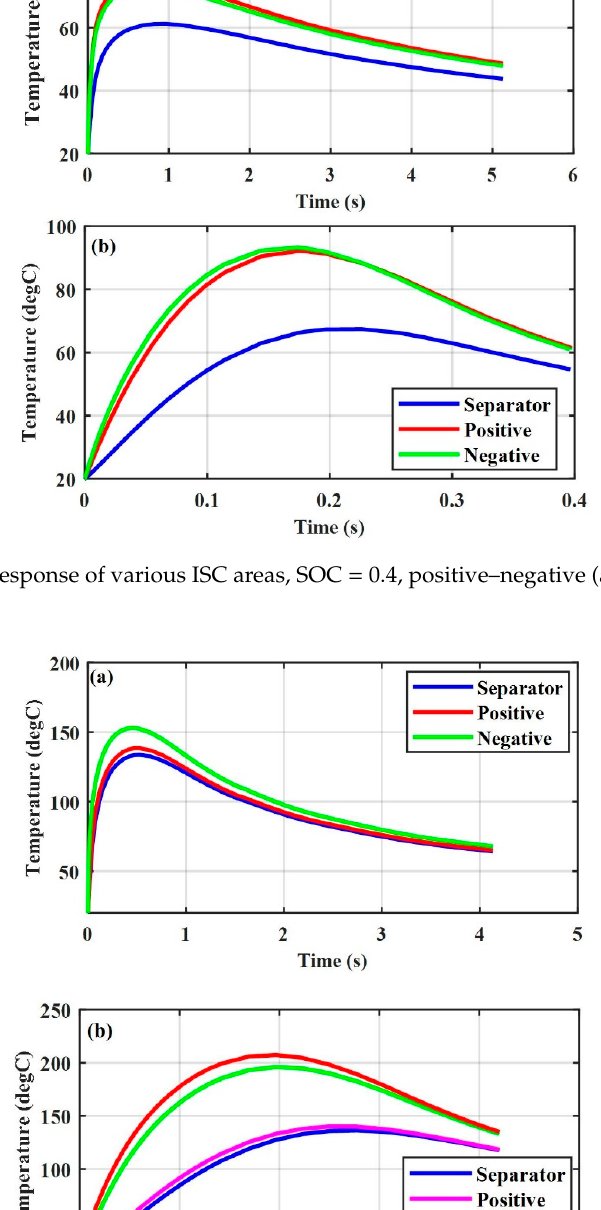
Figure 4. Thermal response of various ISC areas, SOC = 0.4, aluminum-negative ( a ) =0.5 mm ( b ) r in = 1.5